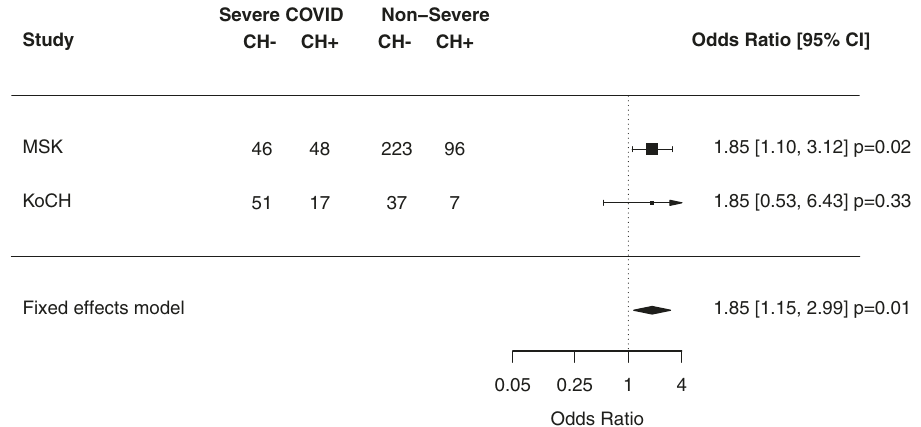
Fig. 1 Association between CH and Covid-19 severity. Shown are the results from logistic regression adjusted for age, gender, race, smoking, diabetes, cardiovascular disease, COPD/asthma, BMI, and month of Covid-19 diagnosis in 525 individuals. The MSK cohort was also adjusted for cancer primary site, exposure to cytotoxic cancer therapy before and after blood draw. Summary statistics for a fi xed-effects meta-analysis are shown. Any CH includes both driver (CH-PD) and non-driver mutations